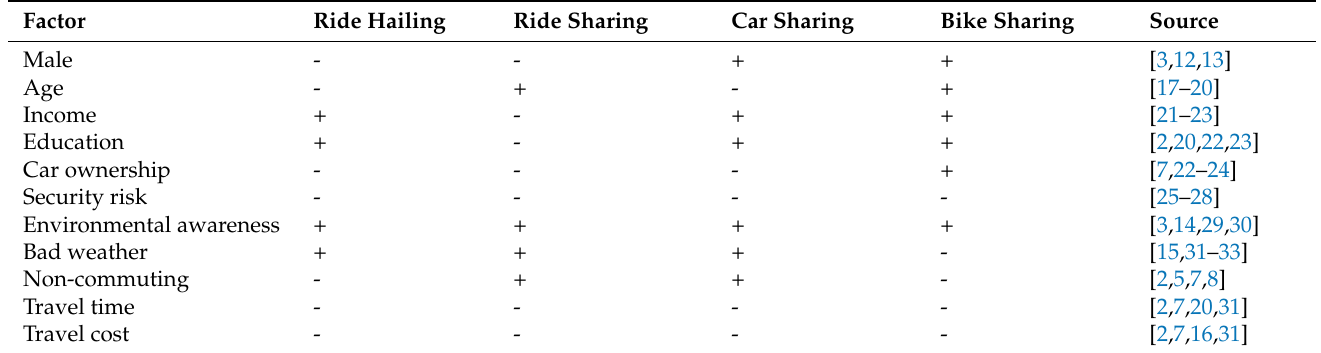
Table 1. Summary of factors that influence shared mobility use in the